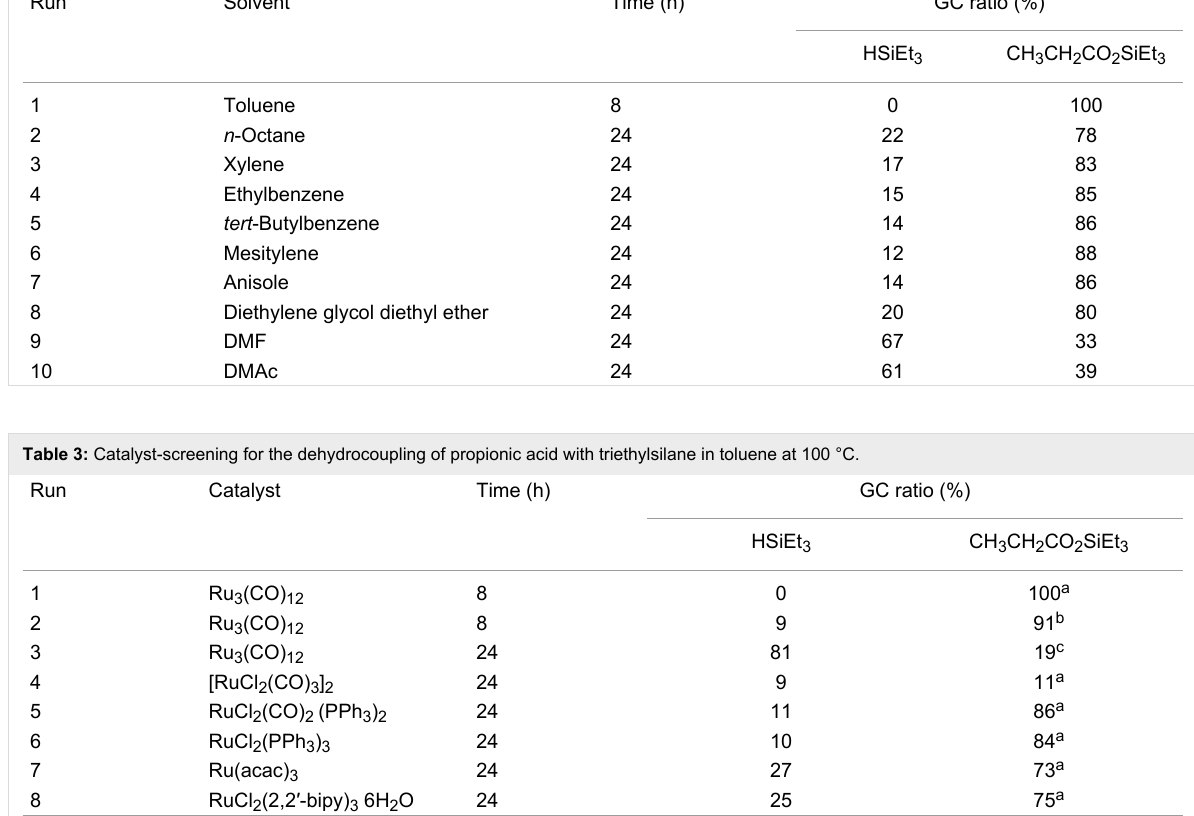
Table 2: Ru 3 (CO) 12 -catalyzed dehydrocoupling of propionic acid with triethylsilane in different solvents. Run